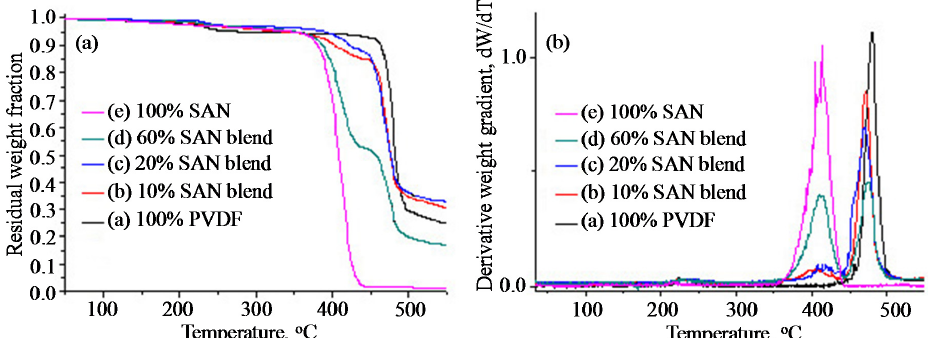
Figure 5. ( a ) Degradation behavior; ( b ) Degradation rate of styrene ‐ acrylonitrile ‐ blended PVDF membranes.